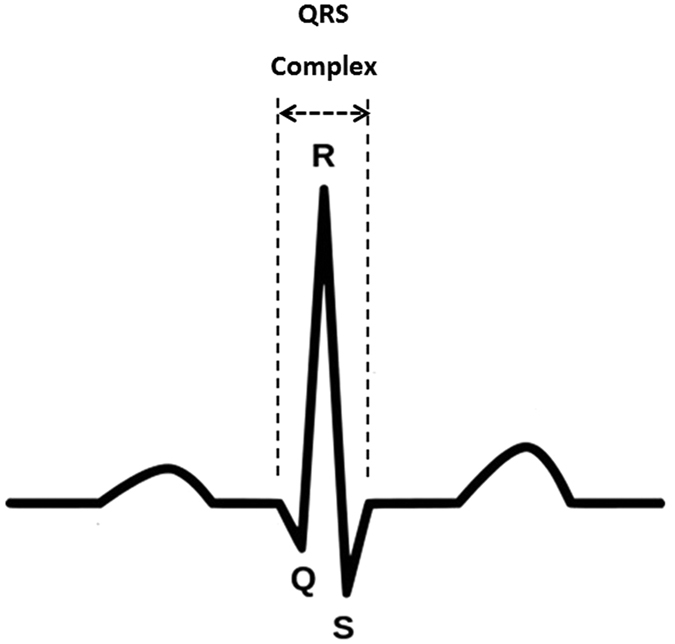
A schematic of QRS complex.